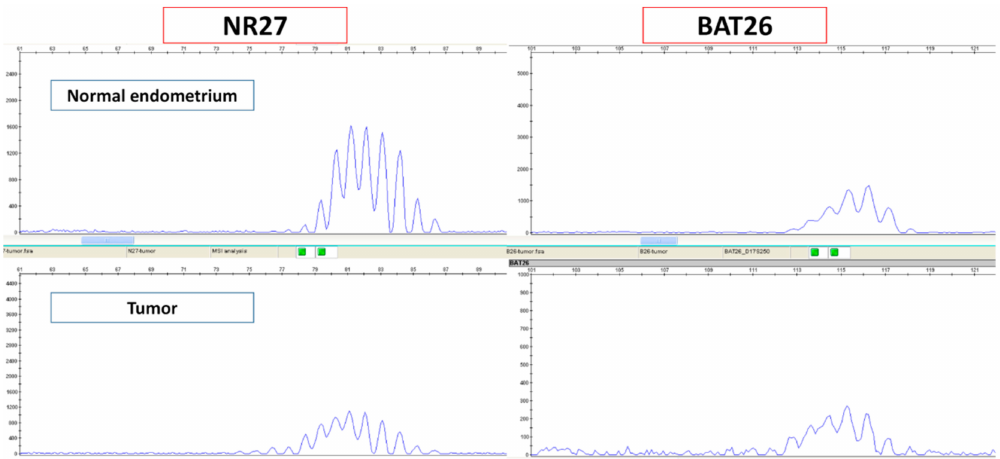
Figure 5. Cases that were evaluated as MSI by immunohistochemistry were further validated by MSI